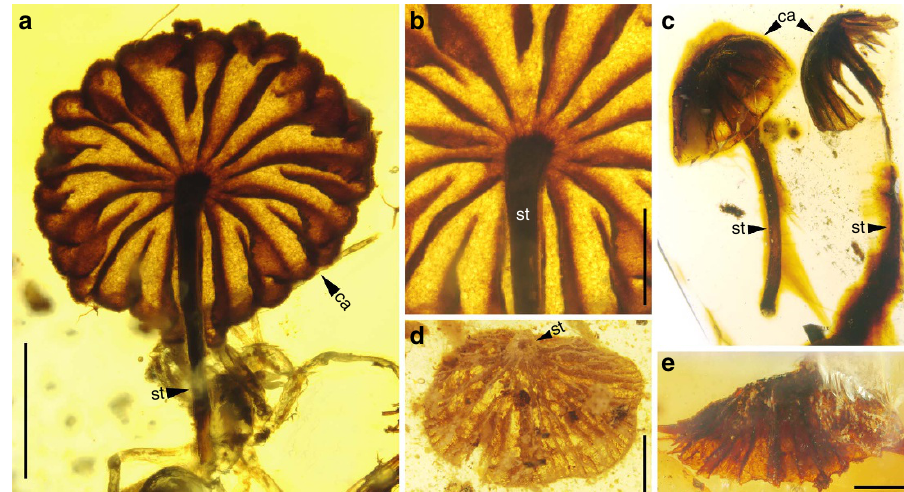
Figure 1 | Diverse mushrooms in mid-Cretaceous amber from northern Myanmar. ( a ) General habitus of Taxon A, FXBA10101, ventral view. ( b ) Enlargement of a , showing details of lamellae and top portion of stalk. ( c ) Lateral view of two individuals of Taxon B, NIGP164521 (left) and NIGP164522 (right). ( d ) Ventral view of Taxon C, NIGP164523, showing sub-marginally inserted stalk. ( e ) Lateral view of Taxon D, NIGP164524. Abbreviations: ca, cap; st, stalk. Scale bars, 1mm ( a , c , d ); 500 m m (others). NATURE COMMUNICATIONS|8:14894|DOI: